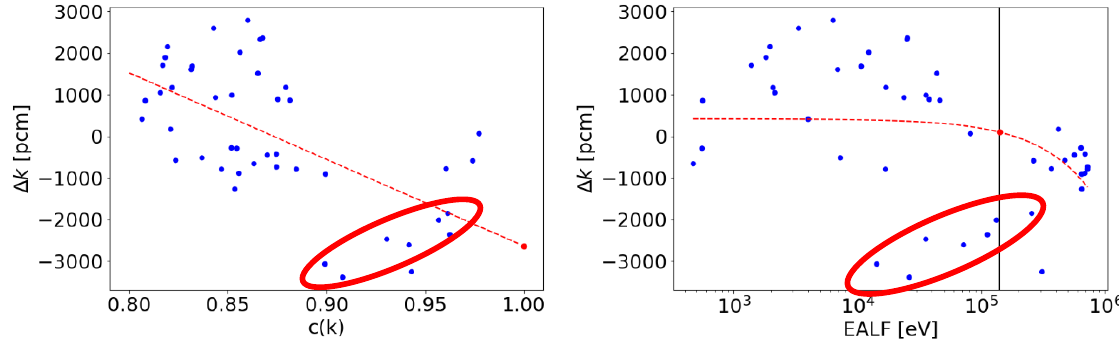
Figure 3b and 3c. The error between the model and the corresponding experiment as a function of c